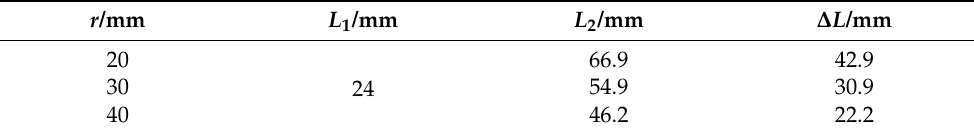
Table 2. Parameters of constraint part movement on holding cherry tomatoes.